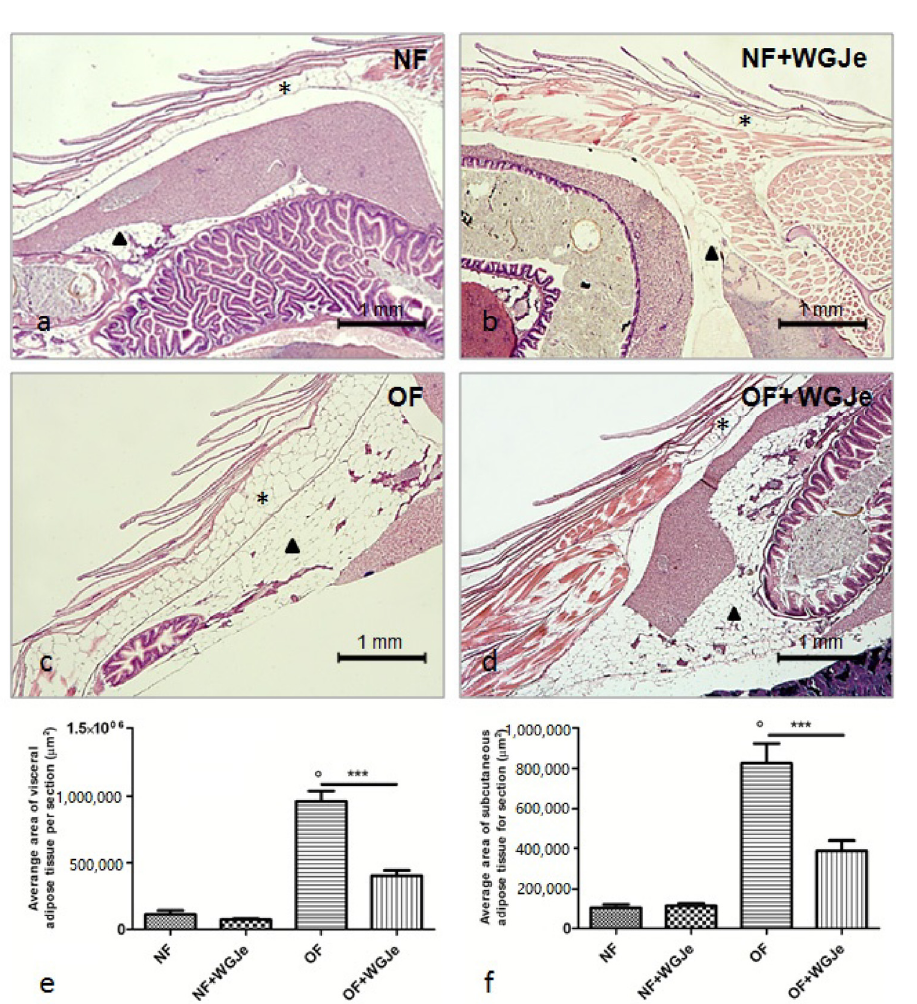
Figure 3. Histological micrographs of adipose tissue in the four experimental groups performed using hematoxylin and eosin staining ( a – d ). Morphometric analysis of visceral and subcutaneous total areas of adipose tissue ( e , f ). The fat deposit was poorly represented in both visceral and subcutaneous tissues of the NF group ( a , e , f ). Additionally, by the end of the experiment, the treated NF group did not show a significant change in fat deposit with respect to its untreated counterpart ( b , e , f ). The difference of the aforementioned tissues was statistically significant in the OF group with respect to the NF one ( c , e , f ). Similarly, the decrease at the end of the WGJe treatment in OF fish was statistically significant with respect to OF fish ( d , e , f ). Photos ( a – d ) are representative of those (three per section) taken in 10 fish per group. The values in graphs ( e , f ) are expressed in µm 2 of adipose tissue per section. Scale bars are 1 mm. Subcutaneous adipose tissue is indicated with an asterisk, while visceral one with an arrowhead. Data presented in the graphs are the mean ± SD of 10 fish per group. *** p < 0.001 vs. respective counterpart; ° p < 0.001 vs. NF.